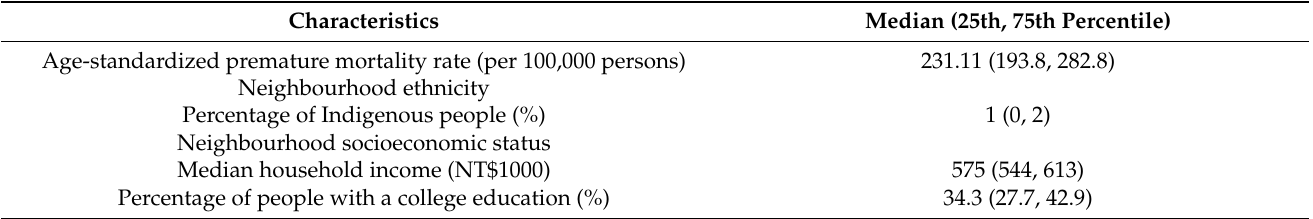
Table 1. Descriptive statistics of premature mortality and neighbourhood SDOH ( n = 349).